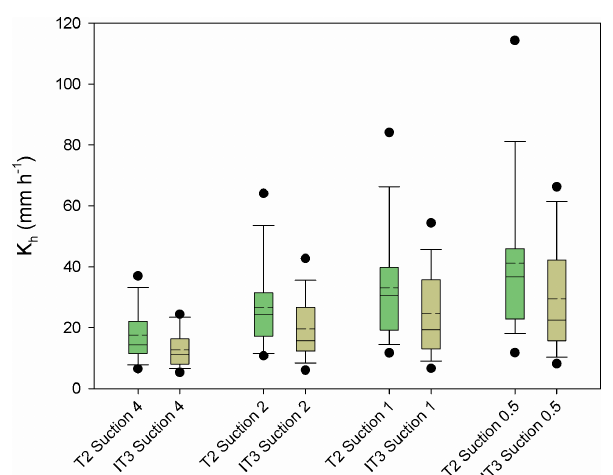
Figure 6. Box plots showing the unsaturated hydraulic conductiv- ities ( K h ) values for suctions 4, 2, 1 and 0.5 for T2 (near tree drip line; within tree area) and IT3 (near tree drip line; outside tree area) sampling locations. Median – solid line; mean – dashed line; dots – 5th and 95th